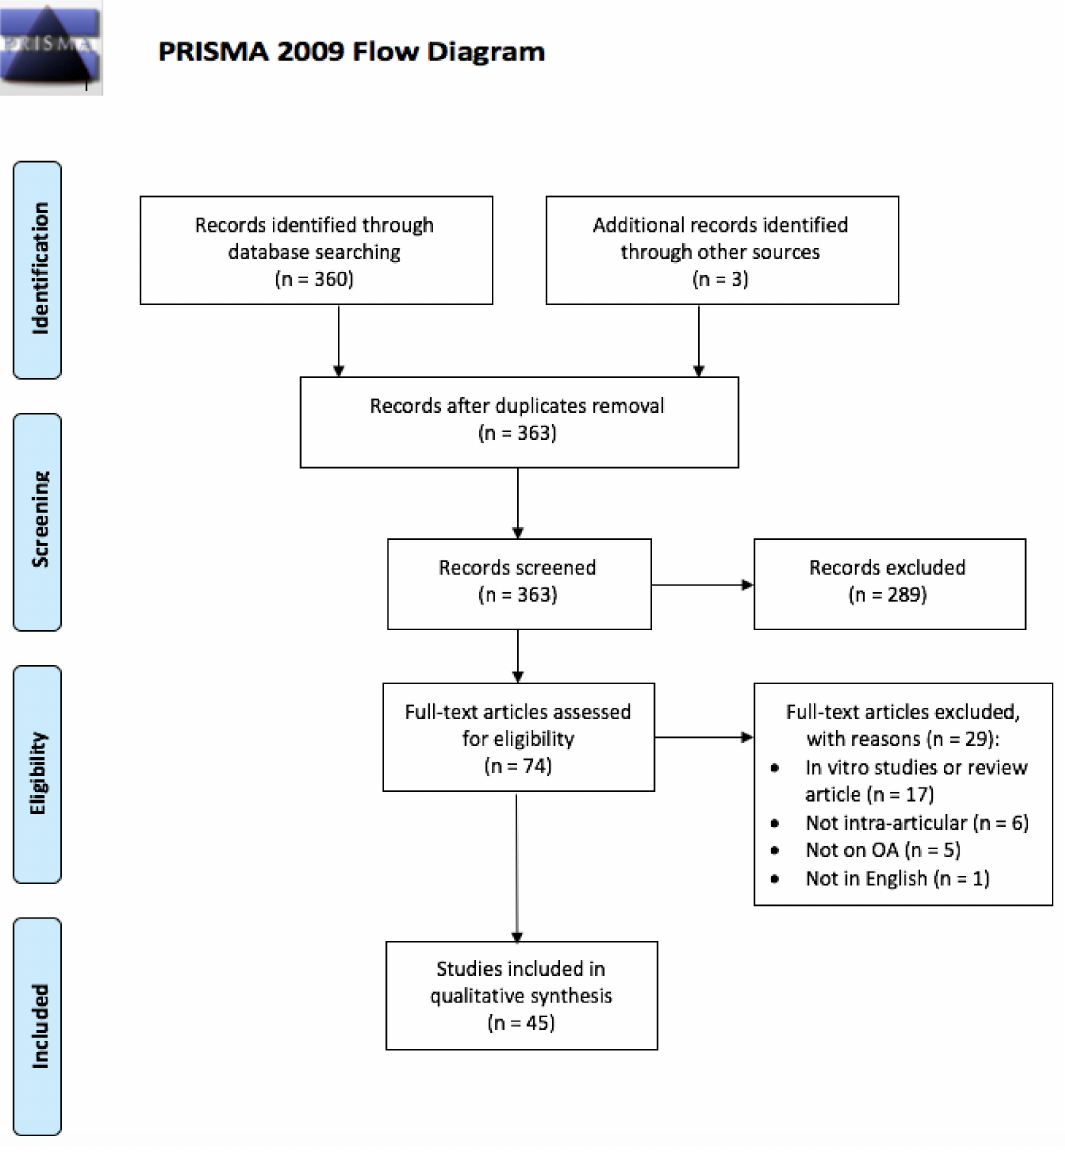
Figure 2. PRISMA Flowchart summarizing the papers’ selection process. Legend: OA: